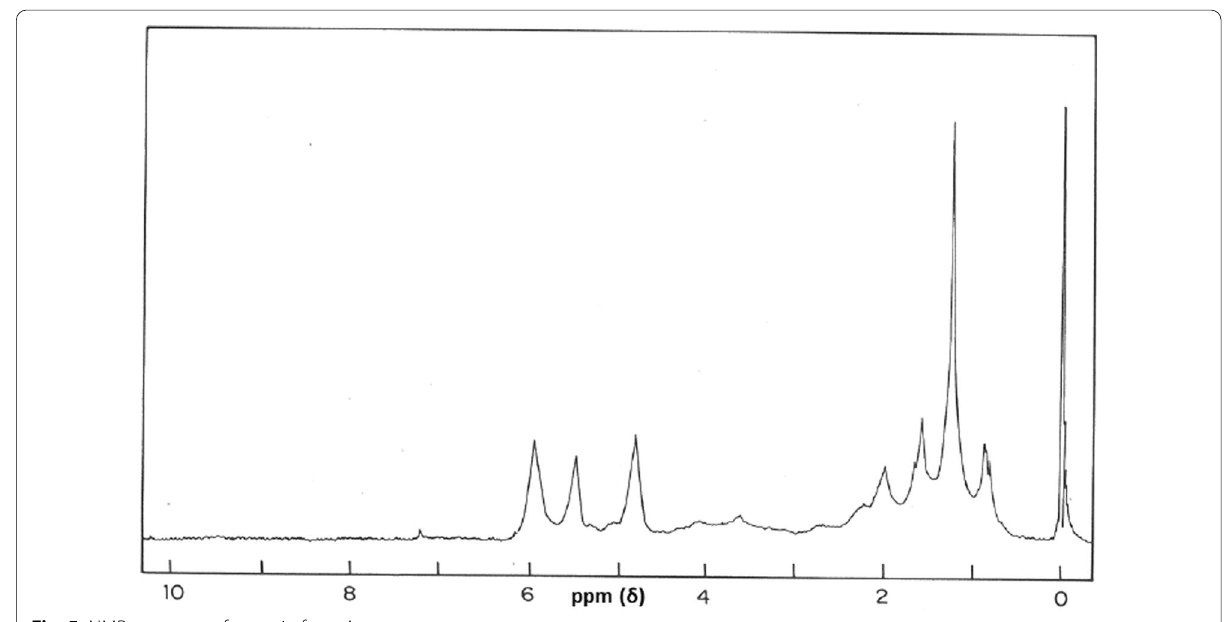
Fig. 5 NMR spectrum of saponin from A. racemosus